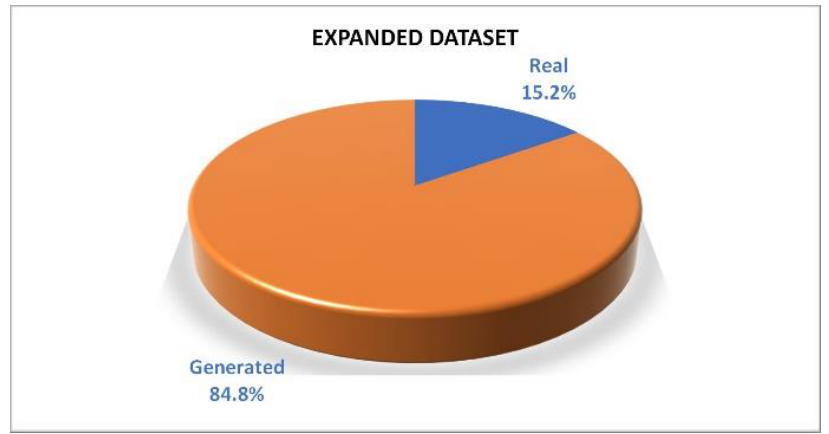
Figure 11. The percentage of real images and generated images.